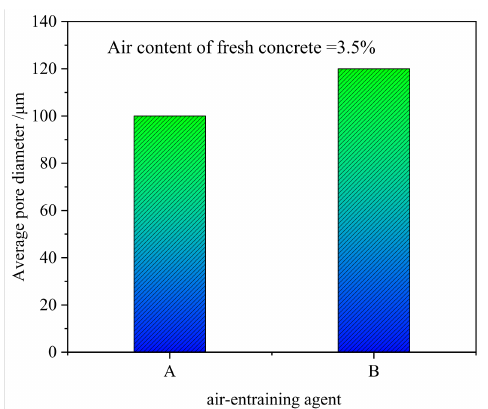
Figure 12. Effect of air-entraining agents A and B on the average bubble